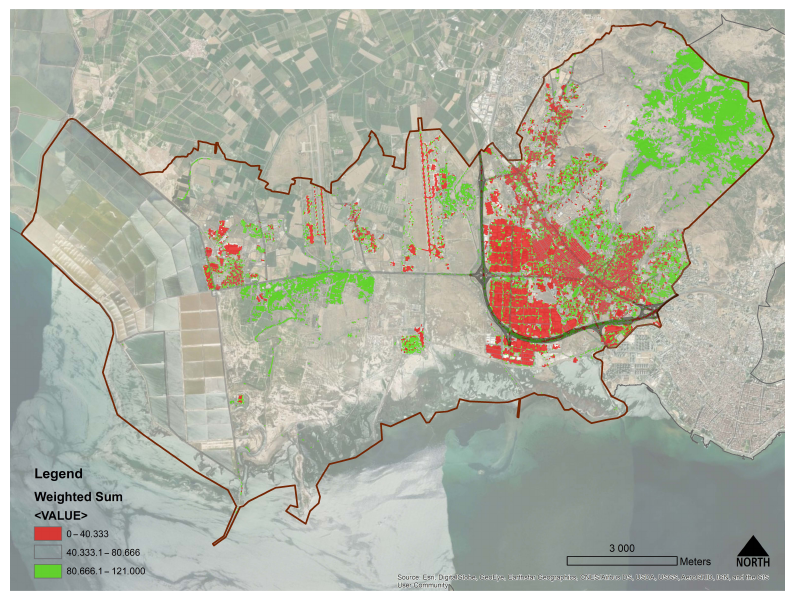
Figure 8. Weighted Sum Result (source: author’s elaboration).